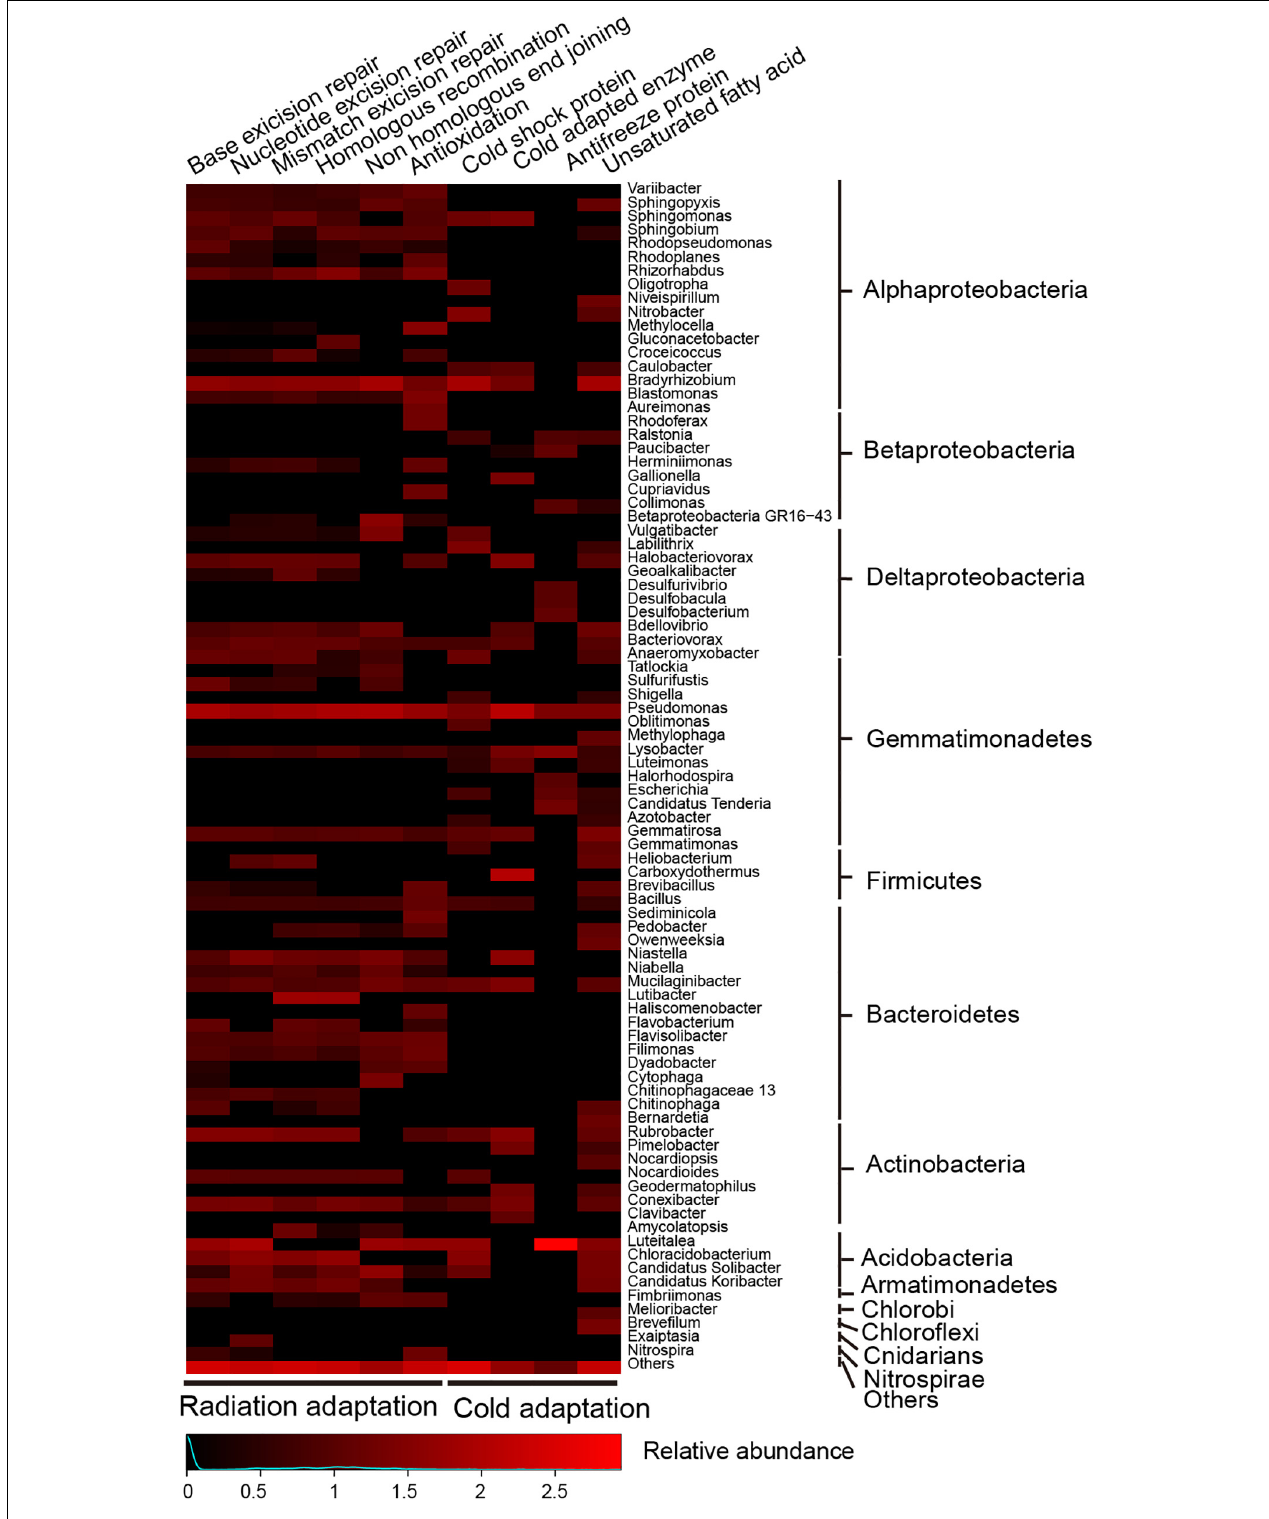
FIGURE 7 | Heatmap showing relative abundances for main microbes (only for those that contributed > 1% of the marker genes mixture) potentially driving DNA repair, antioxidation and cold adaption to an extremely low temperature in the Union Glacier area. Color bars represent the row-scaled value, in which a blue curve illustrates the distribution density